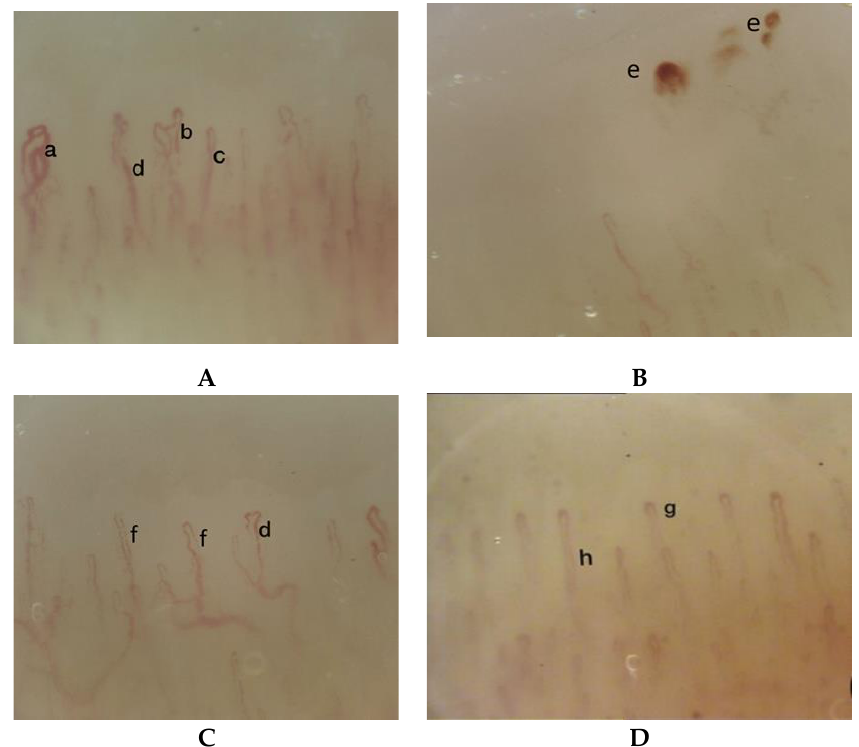
Figure 2. Nailfold videocapillaroscopic images in an archer showing a “ non-specific pattern ” in right hand ( A , B , C ) and a normal pattern in left hand ( D ): ( A ) Right hand, second finger: a) ectatic “treble clef” loops capillary, b) “antler” loops, c) single tortuosity of the capillary, d) ectasia of the efferent tract of the loops; ( B ) Right hand, fourth finger: e) microbleeding; ( C ) Right hand, third finger: f) granular flow, d) ectasia of the efferent tract of the loops; ( D ) Left hand, second finger: g) ”U - shaped” loops, capillaries regularly arranged in a parallel fashion, h) ratio efferent limb < 2:1.